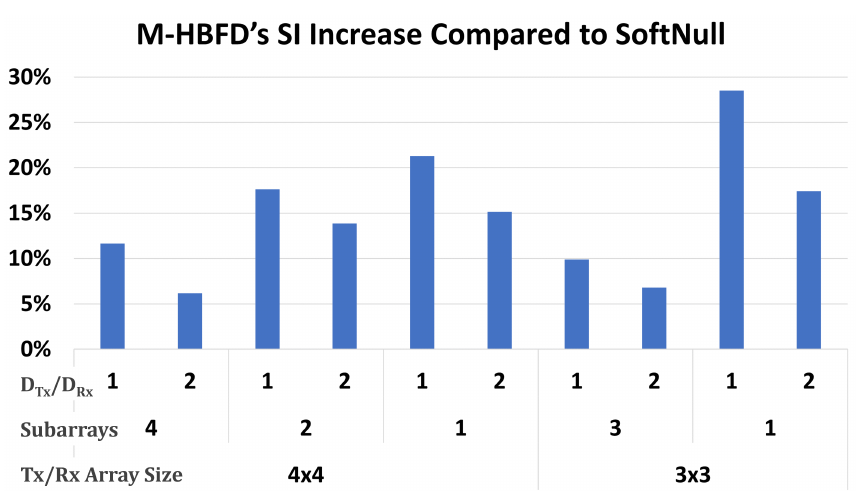
Figure 7. Effect of array size (bottom label, and denoted by Tx/Rx Array Size row), number of subarrays (middle label, and denoted by Subarrays row), and number of effective antennas per row (top label, and denoted by D Tx /D Rx row) on SI compared to